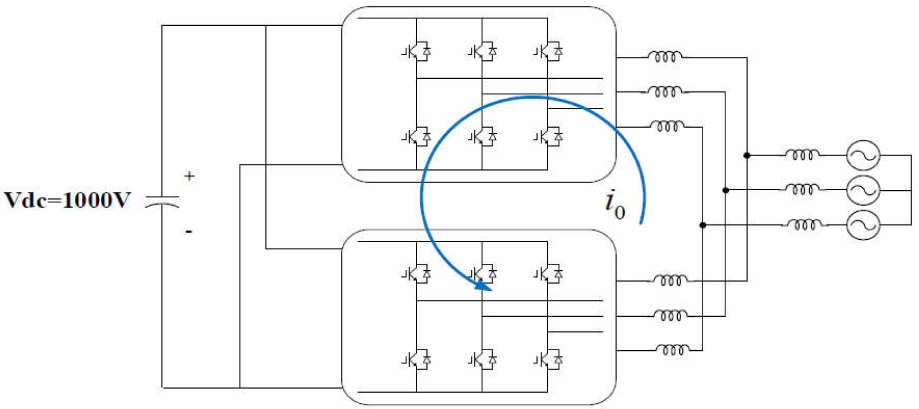
Figure 6. Two parallel configurations of two-level inverters for propulsion.